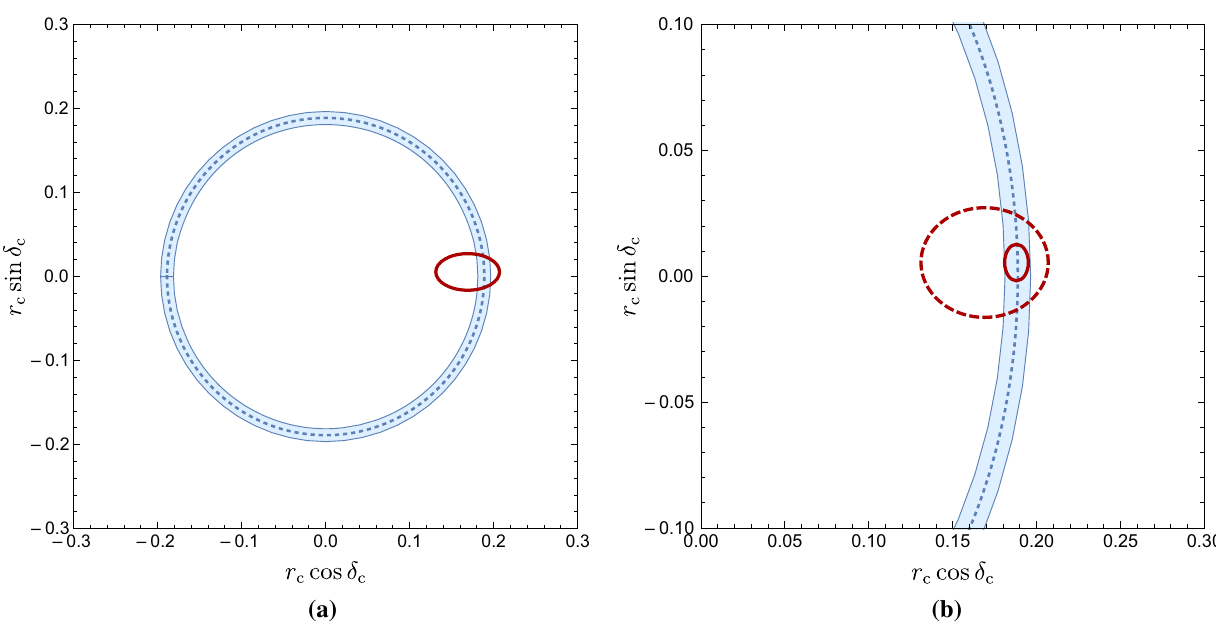
Fig. 3 Constraints on r c and δ c : a the blue circle depicts the 1 σ constraints from Eq. (56) with R T + C | fact while the red ellipse follows from the B → ππ data yielding the results in Eq. (38); b scenario for the expected future precision as discussed in the text